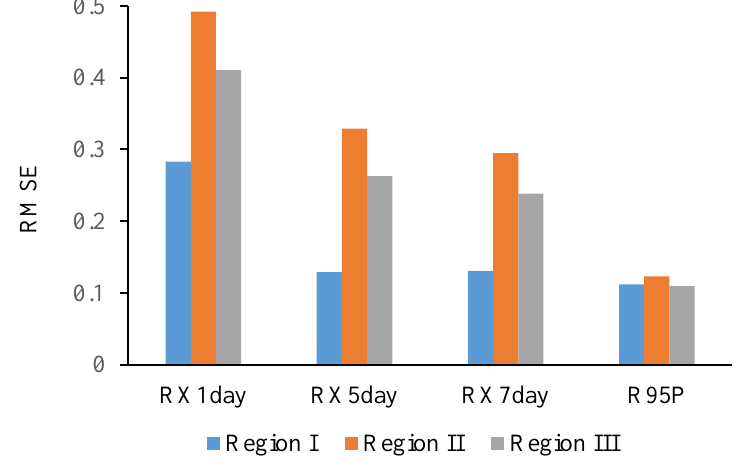
Figure 7. The RMSE values of three HOM regions for RX1day, RX5day, RX7day and R95P when return period is 100 years.